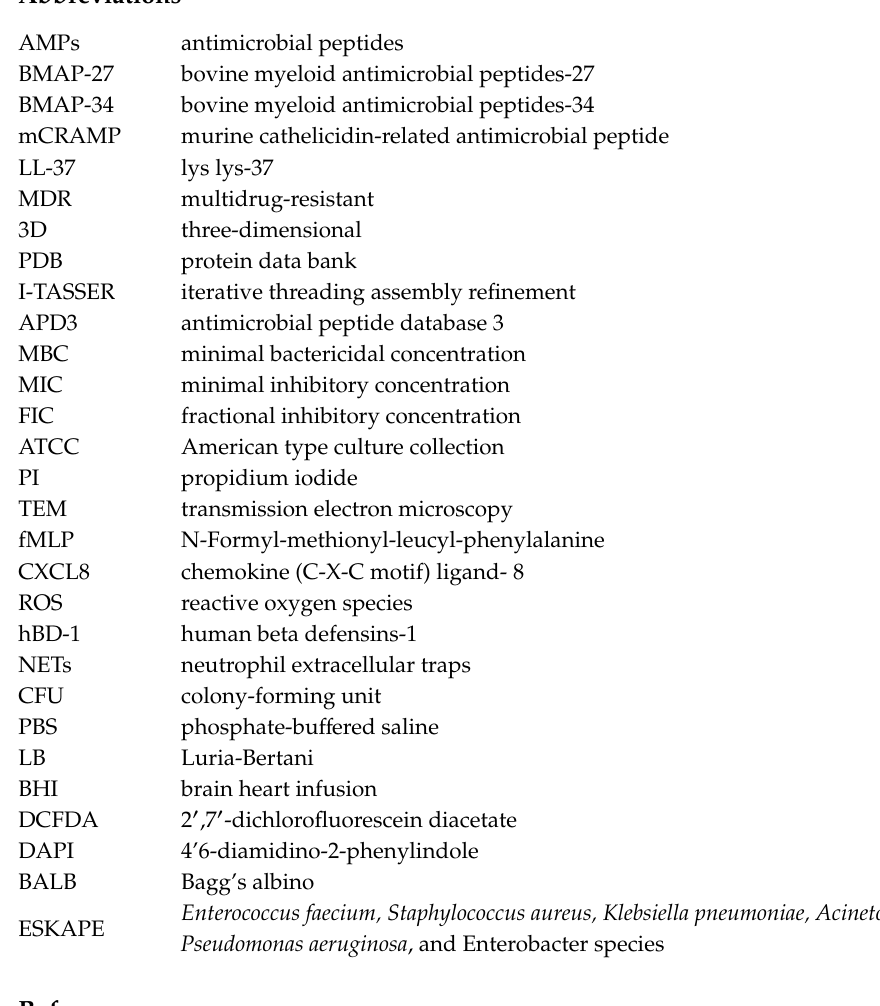
Figure S1: Hemolytic activity of mammalian cathelicidins. 100% hemolysis was established using 0.2% Triton X-100 (ATriton). Percentage hemolysis was calculated as follows: hemolysis% = [(ASample − APBS) / (ATriton − APBS)] × 100. Values represent the mean ± SD from three independent assays, Table S1: MIC and FIC indices of BMAP-27 in combination with other peptides against P.